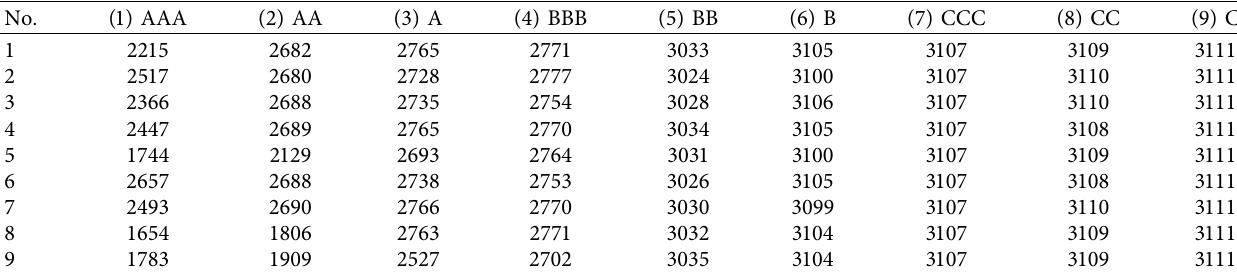
Table 3: Credit rating division of 9 groups satisfying constraint